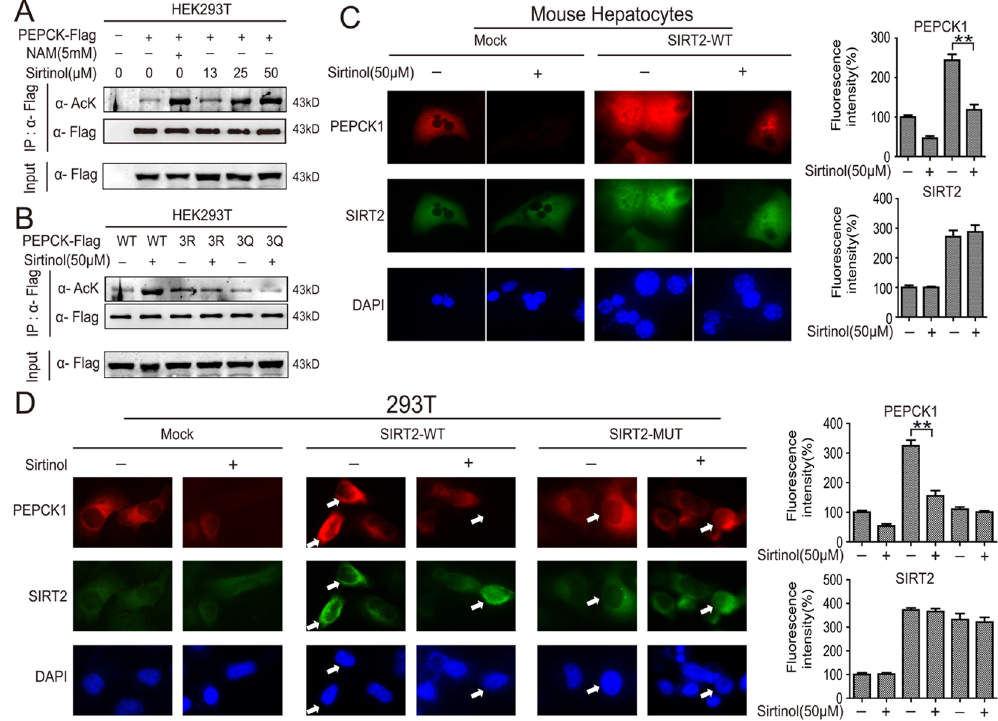
Figure 2. Sirtinol increases the acetylation of PEPCK1 at three key acetylation sites. ( A ) HEK293T cells were transfected with flag tagged PEPCK1 plasmid and then treated with indicated sirtinol for 4 hours. NAM was used as a positive control. Cells were harvested and lysated, then incubated with flag-beads. The immunoprecipitated protein from cell lysates were analyzed via Western blotting and FLAG are shown as loading controls. ( B ) HEK293T cells were transfected with flag tagged wild type or mutant PEPCK1 (3K/R and 3K/Q) plasmid, then treated with 50 μ M sirtinol for 4 hours. Cells were harvested and lysated, then incubated with flag-beads, the immunoprecipitated protein from cell lysates were analyzed by Western blotting and FLAG are shown as loading controls. ( C ) Primary mice hepatocytes were transfected with flag tagged SIRT2 plasmid, followed by treatment with 50 μ M sirtinol for 4 hours. PEPCK1 (red), SIRT2 (green) and nucleus (blue) were visualized by indirect immunofluorescence. ( D ) 293T cells were transfected with flag tagged SIRT2 plasmid, followed by treatment with 50 μ M sirtinol for 4 hours. PEPCK1 (red), SIRT2 (green) and nucleus (blue) were visualized by indirect